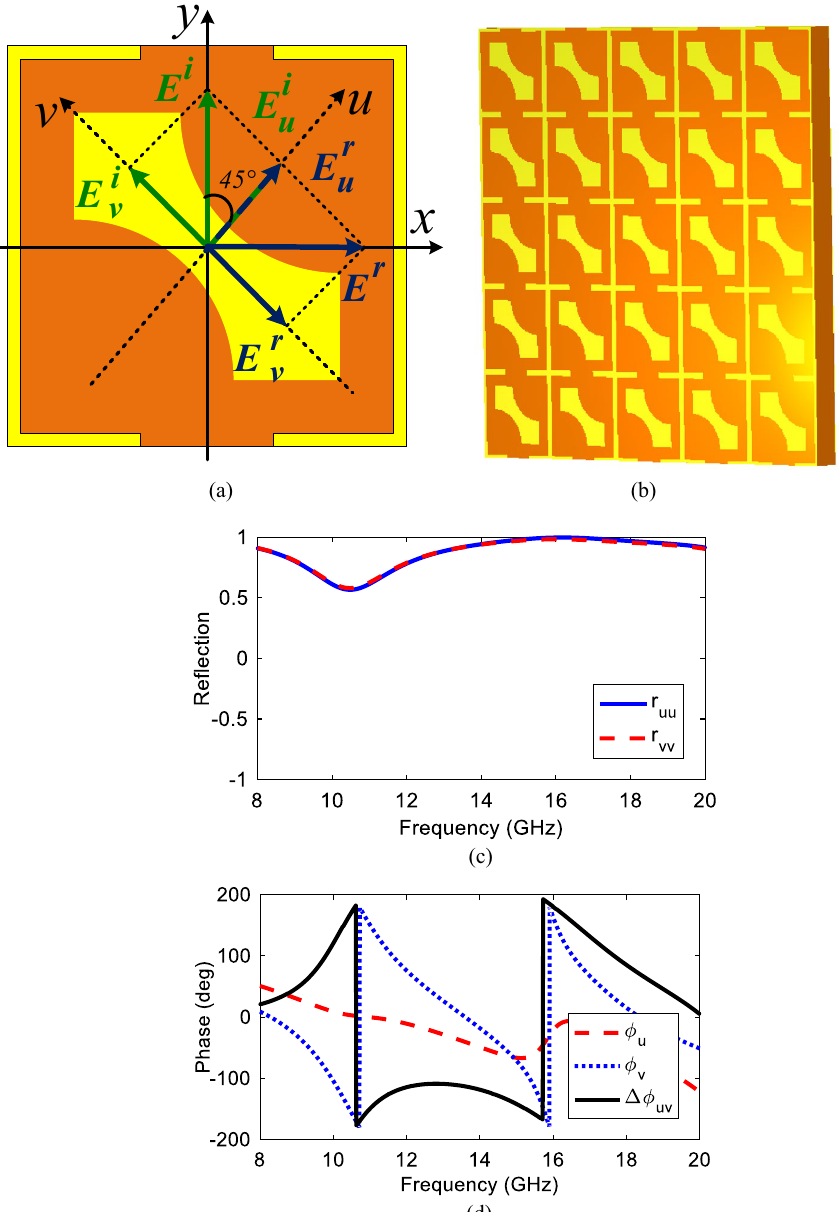
Figure 5. ( a ) The proposed unitcell in new coordinate system, ( b ) 5 × 5 array, ( c ) reflection magnitude, ( d ) phase and phase